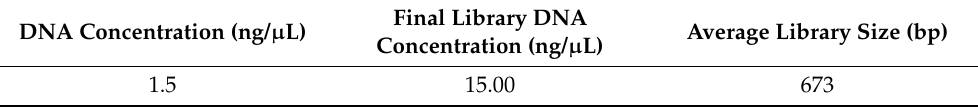
Table 3. DNA, final library concentration, and average library size. Final Library DNA Concentration (ng/ µ L)